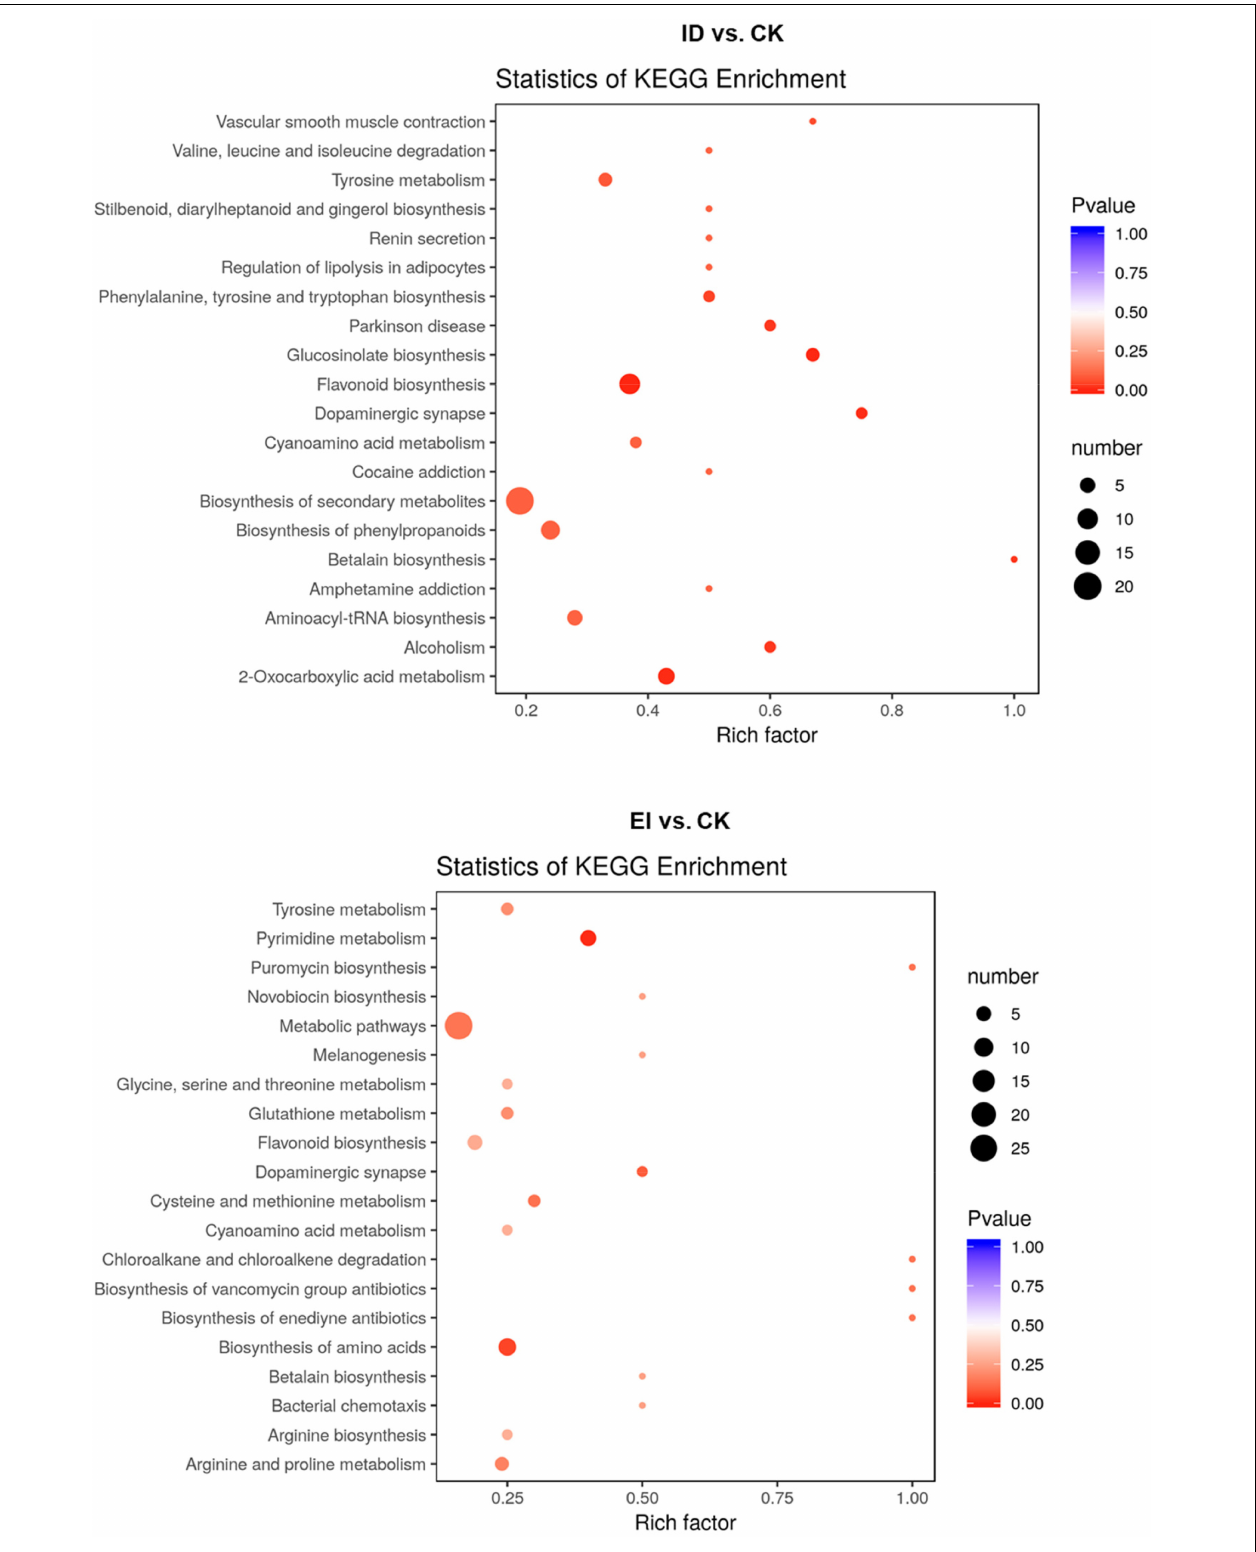
FIGURE 7 | Scatter plot analysis of the DAMs in response to the ID and EI treatment in A. catechu seedlings leaves.